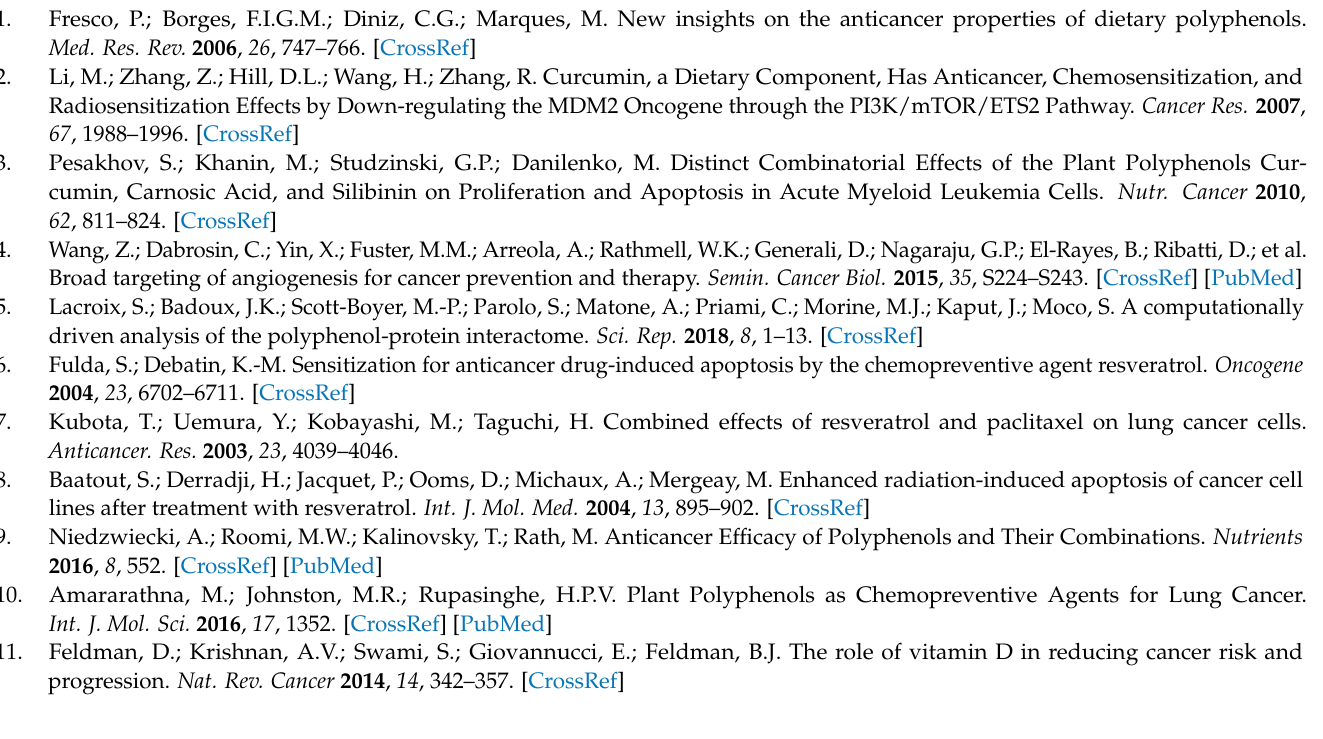
Figure S6: Western blot analysis of (A) p53 and (B) p21 expression in lung cancer cells treated with PRI-2191 (100 nM) and RESV (20 µ M), Figure S7: Western blot analysis of (A) CYP24A1, (B) RXR α , and (C) vitamin D receptor (VDR) expression in lung cancer cells treated with PRI-2191 (100 nM) and RESV (20 µ M), Figure S8: Analysis of SIRT1, RXR α , and VDR expression in lung cancer cells treated with PRI-2191 (100 nM) and RESV (20 µ M) using qPCR, Figure S9: Analysis of vascular endothelial growth factor A (VEGFA) expression in lung cancer cells treated with PRI-2191 (100 nM) and RESV (20 µ M) using PCR, Figure S10: Analysis of osteopontin (OPN) expression in lung cancer cells treated with PRI-2191 (100 nM) and RESV (20 µ M) using PCR, Figure S11: Analysis of interleukin 8 (CXCL8) (IL-8) expression in lung cancer cells treated with PRI-2191 (100 nM) and RESV (20 µ M) using PCR, Figure S12: Analysis of PD-L1 expression in lung cancer cells treated with PRI-2191 (100 nM) and RESV (20 µ M) using